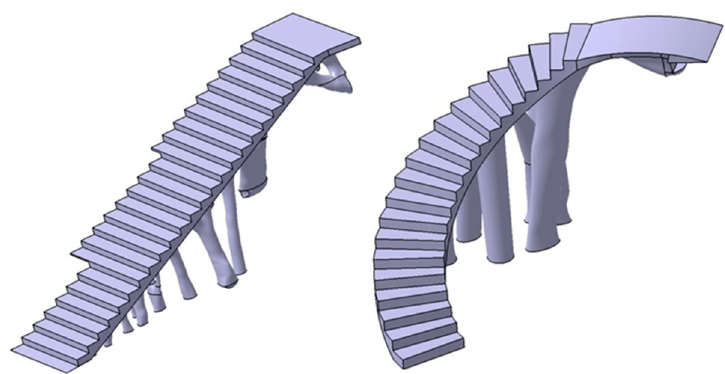
Figure 20. Final CAD model of the BIM type construction elements, E 1 ( left ) and E 2 ( right ).